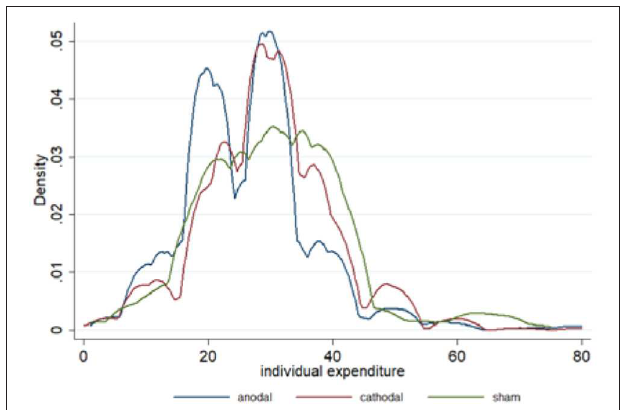
FIGURE 4 | Kernel density comparison of the distribution of individual expenditures in the anodal, cathodal, and sham conditions across 20 periods. Kernel density estimates were computed using STATA 11.0 and Silverman bandwidth selection.